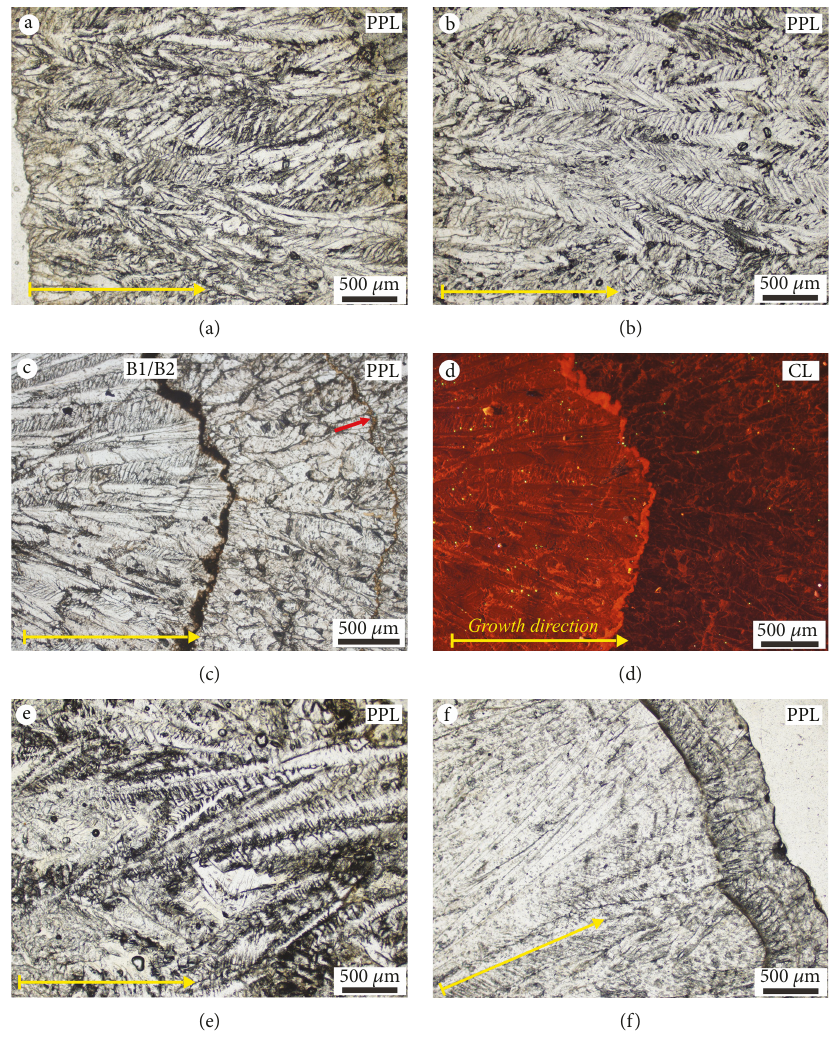
Figure 12: Inner structure of the thick carbonate scale (inner part of the sample G-03). The growth direction is marked by yellow arrows. (a) The scale precipitation begins with a thin ( < 500 μ m) compact lamina composed of limpid, tightly packed fi brous or bladed crystals (F zone), following a relatively compact dendritic – botryoidal zone (B1 zone). (b) Dendritic and feather-like calcite generation in the B1 zone. (c, d) Spherical growth zones made up of dendritic and bladed crystals and subdivided by a thin, bright luminescent fi lm. Note: B1/B2 boundary (an intermittent brownish stained layer) separates annual operational rhythms. Red arrow indicates a very thin brownish stained layer without luminescence. (e) Feather-like dendrites in the porous B2 zone. (f) Contact of a limpid, tightly packed zone, made up of fi brous crystals and a fi ne, tightly packed zone with turbid crystals in the compact B3 zone. Abbreviations: PPL =plane polarized light; CL